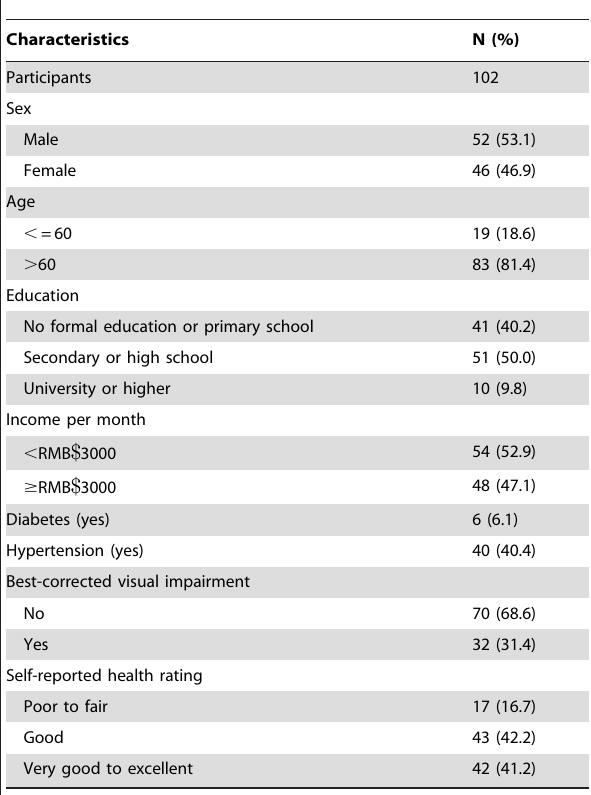
Table 1. Characteristics of the participants.